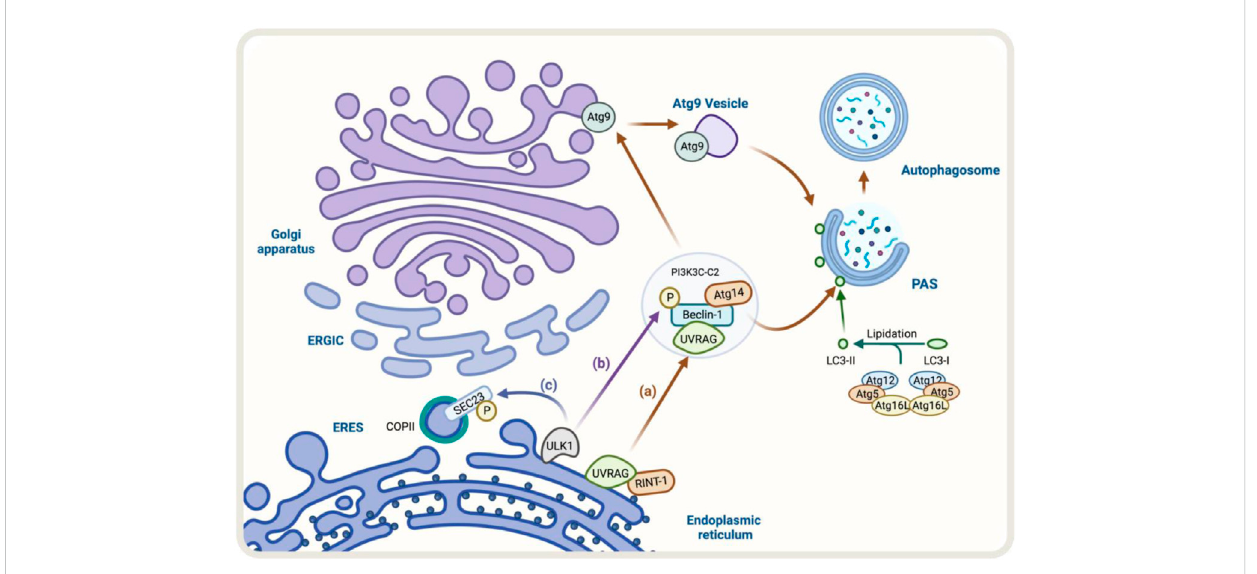
FIGURE 3 Illustrationoftheregulators ofautophagypathway controllingtheearlyconventionalsecretorypathway. (A) UVRAGbindstothePtdIns3P-enriched membranes at the ER where it interacts with RINT-1. During autophagy induction, UVRAG dissociates from the ER to become part of the complex PI3K3C-C2 (for simplicity, only the Beclin-1, Atg14, and UVRAG proteins are shown). The dissociation of UVRAG from the ER inducesthe translocation of the Atg9 vesicles, necessary to promote autophagosome formation (brown arrows) (B) The ULK1 complex can phosphorylate Beclin-1 inducing autophagy (purple arrow). (C) Additionally, ULK1 phosphorylates SEC16A promoting anterograde transport (blue